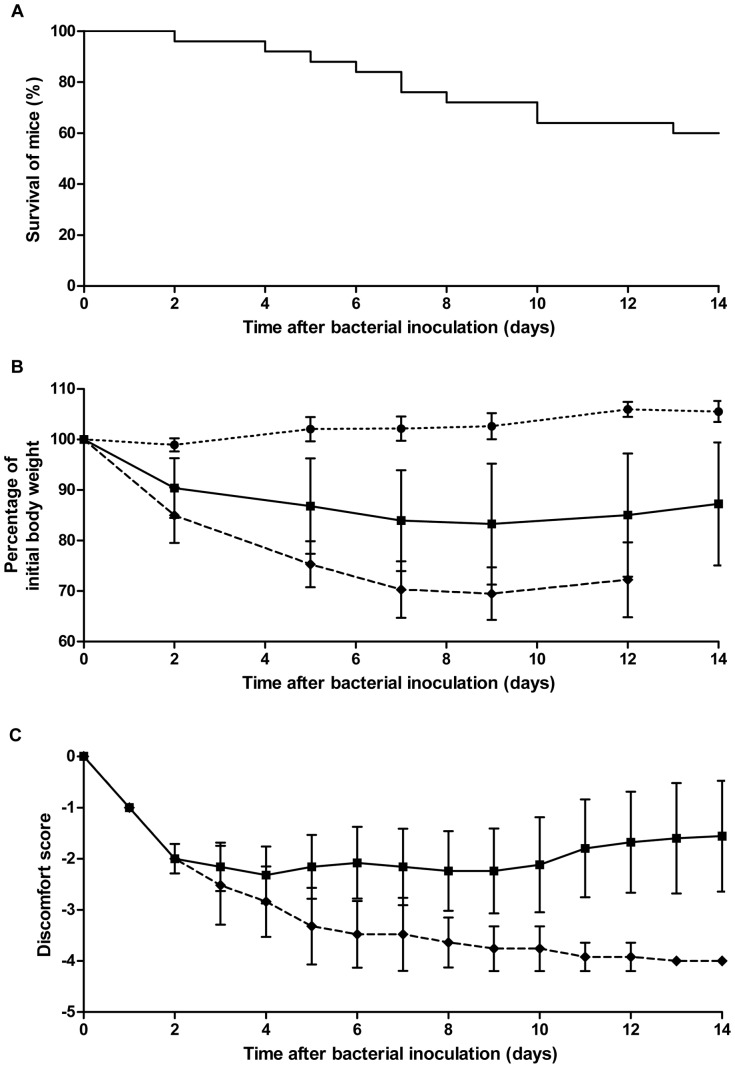
Time course of bacteremia in mice infected with S. aureus at the LD50 inoculum.
A Survival of infected mice (n = 25). B Mouse body weight, shown as mean ± SD (error bars). Body weight of non-surviving infected mice was significantly lower compared to surviving infected mice and to placebo-inoculated mice (P < 0.01; Quade’s rank analysis of covariance). C Discomfort score, shown as mean ± SD (error bars). Discomfort score -2: bad fur. Discomfort score -3: bad fur, hunched back. Discomfort score -4: bad fur, hunched back, instability, euthanasia needed. Placebo-inoculated mice (• n = 12), surviving infected mice (▪ n = 25), non-surviving infected mice (♦n = 25).